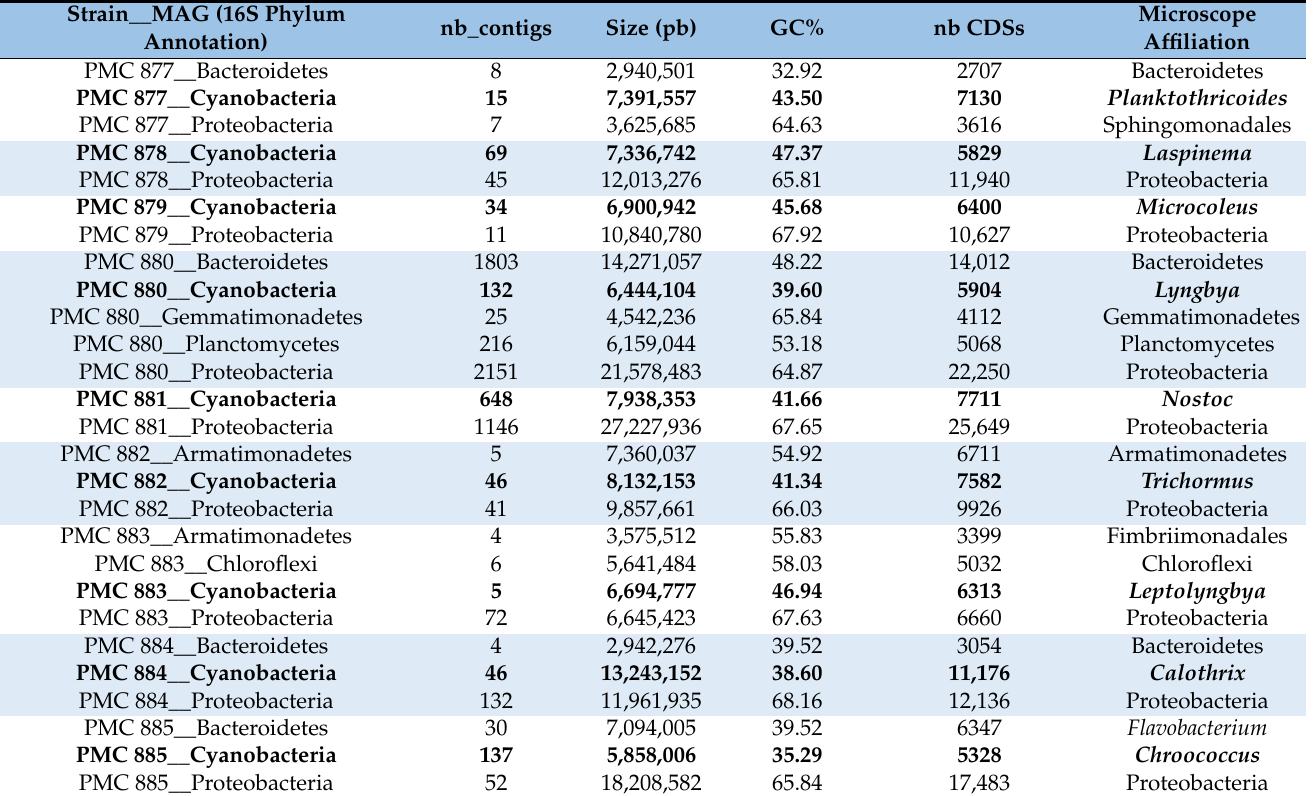
Table 1. Cyanosphere associated-MAG statistics and taxonomic annotations (cyanobacteria in bold, additional information comprising checkM completeness and contamination and taxonomical affilia- tion are indicated on Supplementary Table S2). MAG with the same PMC number were obtained from the same strains